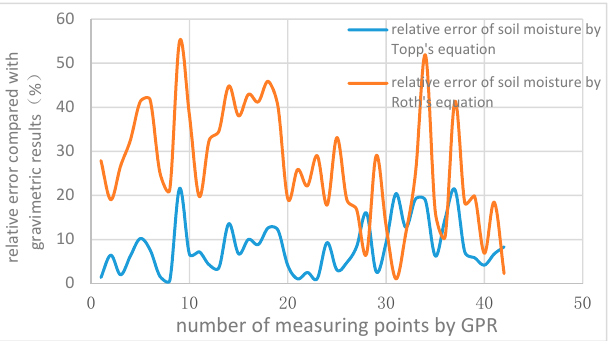
Figure 4. Soil moisture calculated by Topp’s equation and Roth’s equation in comparison with gravimetric method.